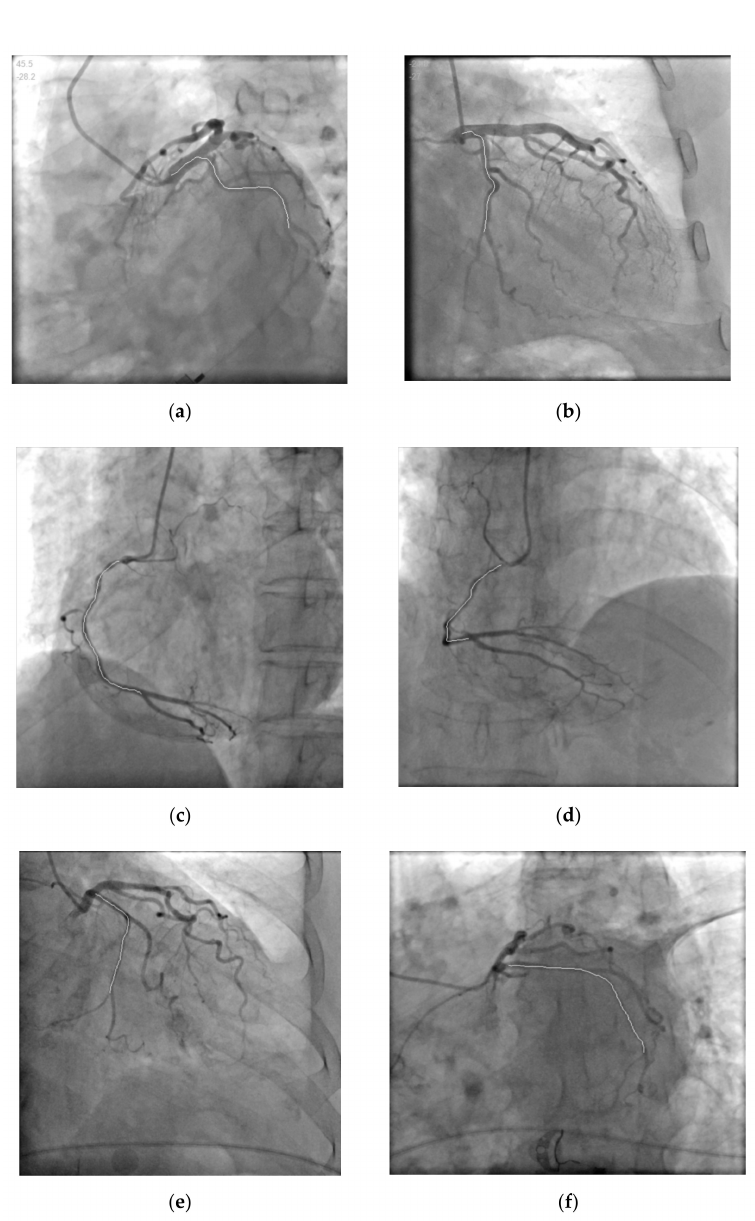
Figure 7. Clinical contrast images for reconstruction. ( a , b ) are Data.1; ( c , d ) are Data.2; ( e , f ) are